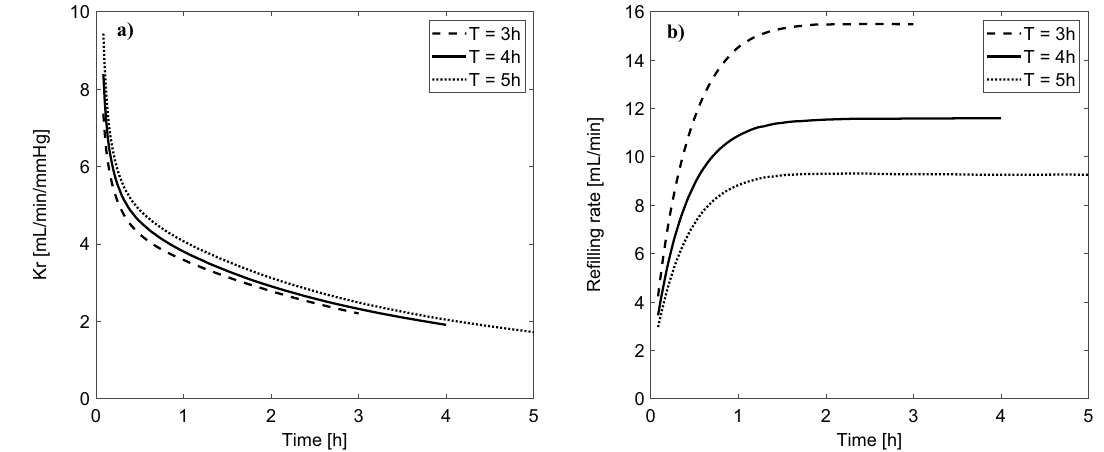
Figure 3. Simulated changes of ( a ) vascular refilling coefficient (Kr) and ( b ) vascular refilling rate (the sum of transcapillary fluid absorption and the total flow of lymph) during hemodialysis sessions of different duration (priming saline discarded) with the same total ultrafiltration of 3L and the whole-body capillary hydraulic conductivity (L p S) of 6 mL/min/mmHg.